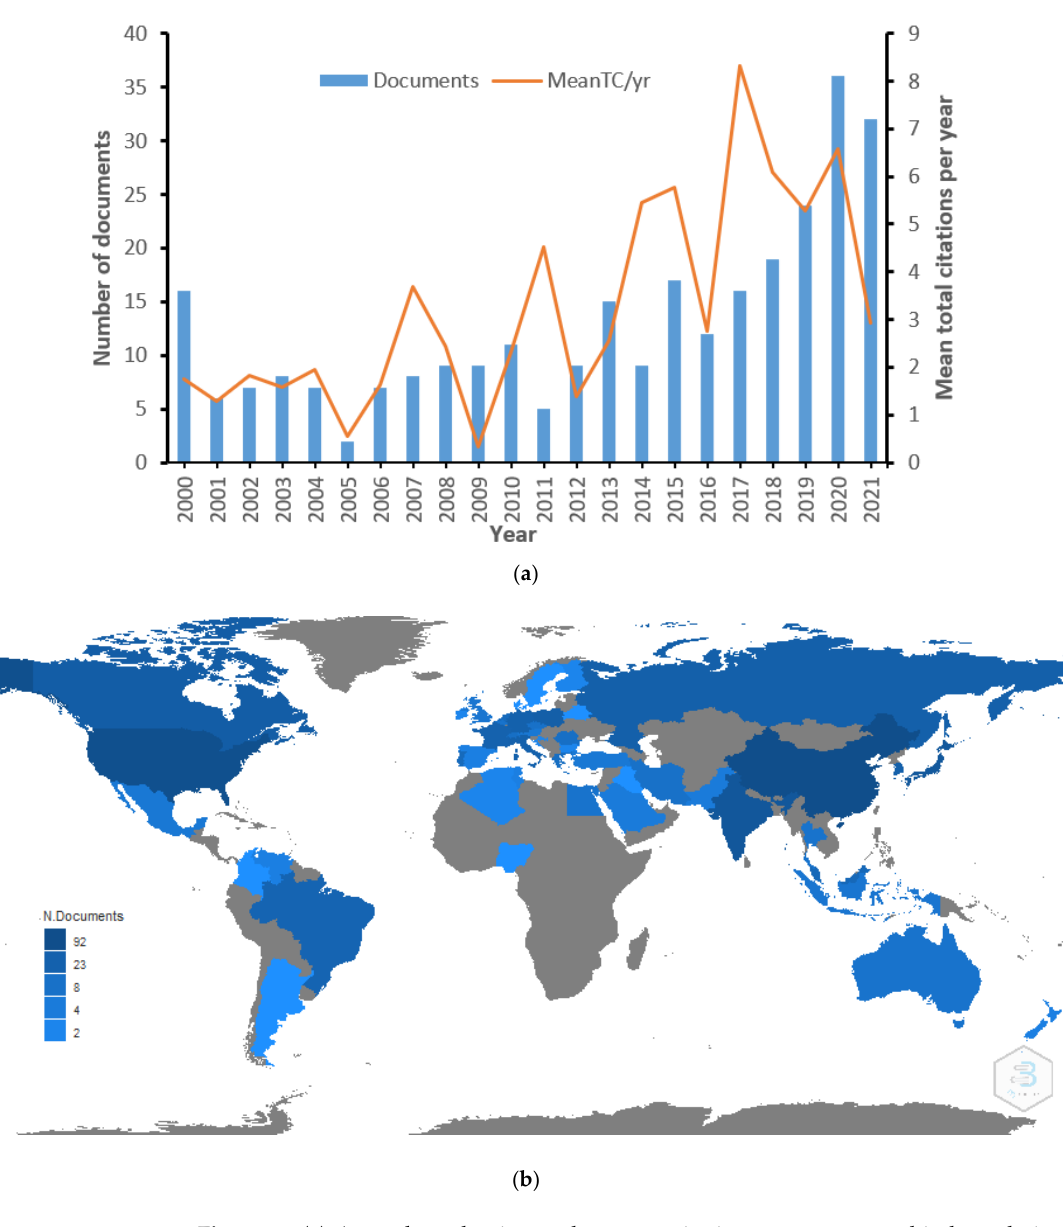
Figure 1. ( a ) Annual production and average citation per annum on biodegradation-of-plastics- related research from 2000 to 2021. ( b ) Country scientific production on biodegradation-of-plastics- related research.